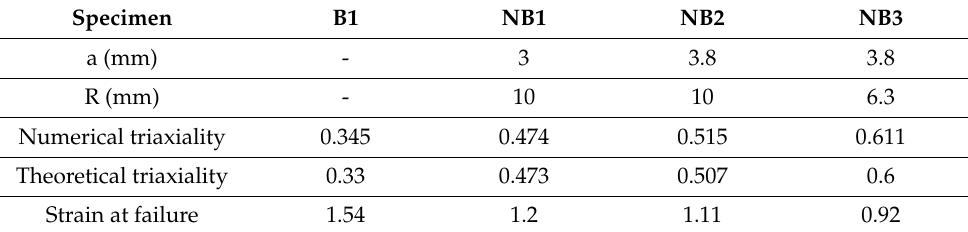
Table 6. Comparison between theoretical and numerical triaxiality for AISI1045 material. Specimen